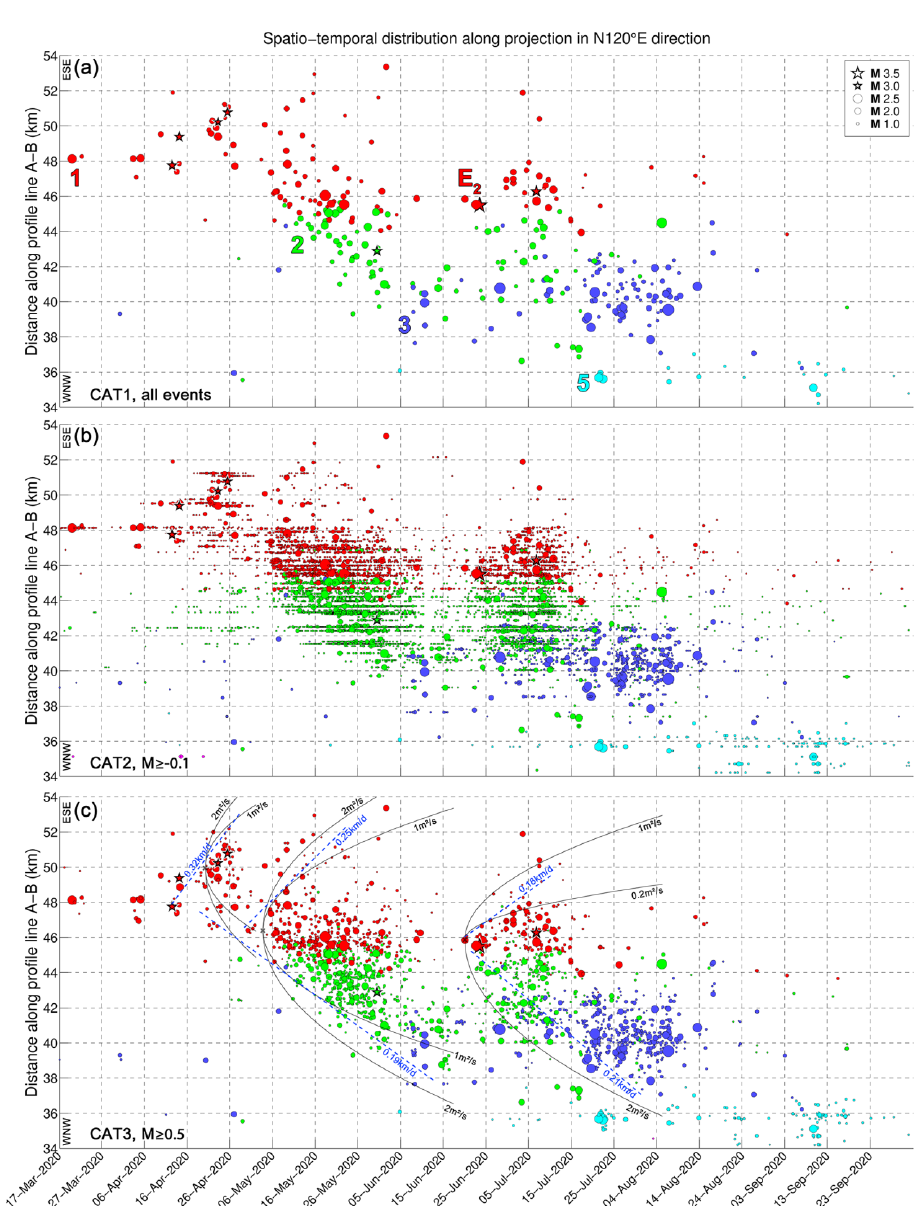
Figure A1. Close-up of the rectangle in Figure 9b, showing the main part of the 2020 Perachora swarm for the three different catalogs: ( a ) catalog CAT1 (templates only) for all events, ( b ) catalog CAT2 (templates and single-channel detections at station LTK with fixed hypocenters to the templates) for events with M ≥ − 0.1, ( c ) catalog CAT3 (templates and multi-channel detections, relocated) for events with M ≥ 0.5. Colors and numbers (panel ( a )) correspond to the spatial groups of Figure 9, while E 2 marks the major event of 23 June 2020 in group #1 (red). In panel ( c ), blue dashed lines and labels show the migration speed in km/day along the direction of the projection (N120 ◦ E), while black parabolic envelopes indicate triggering fronts of pore pressure diffusion with different values of hydraulic diffusivity, D , in m 2